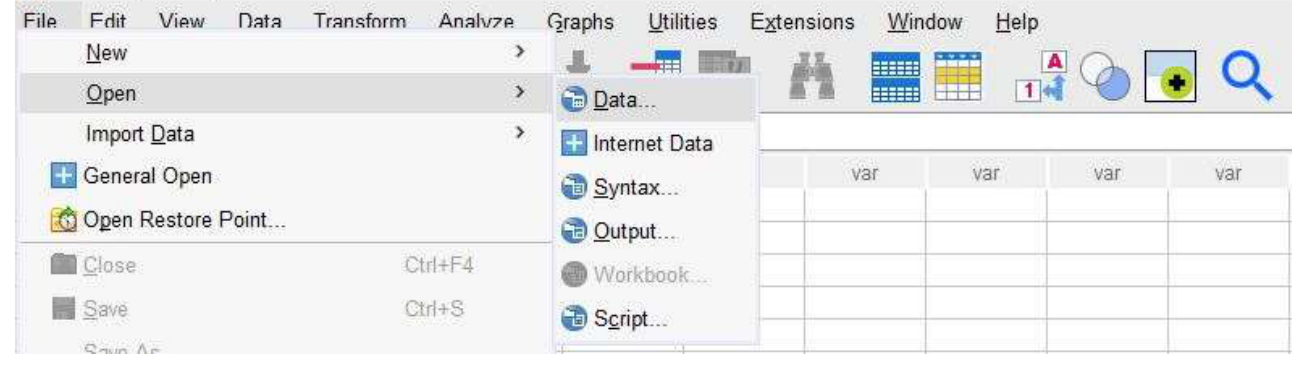
Figure 3. Open Data Menu.